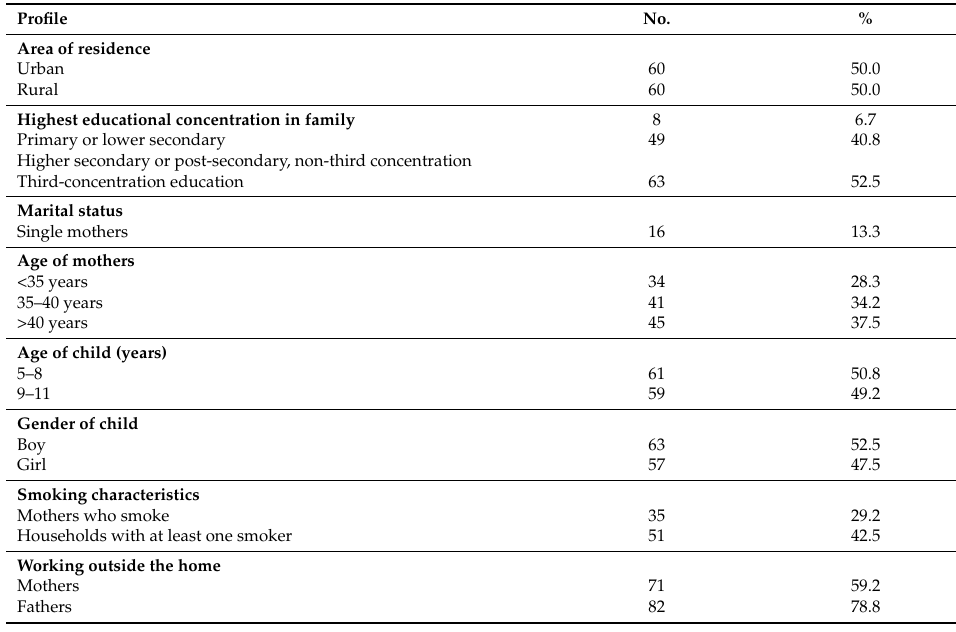
Table 2. Sociodemographic profile of